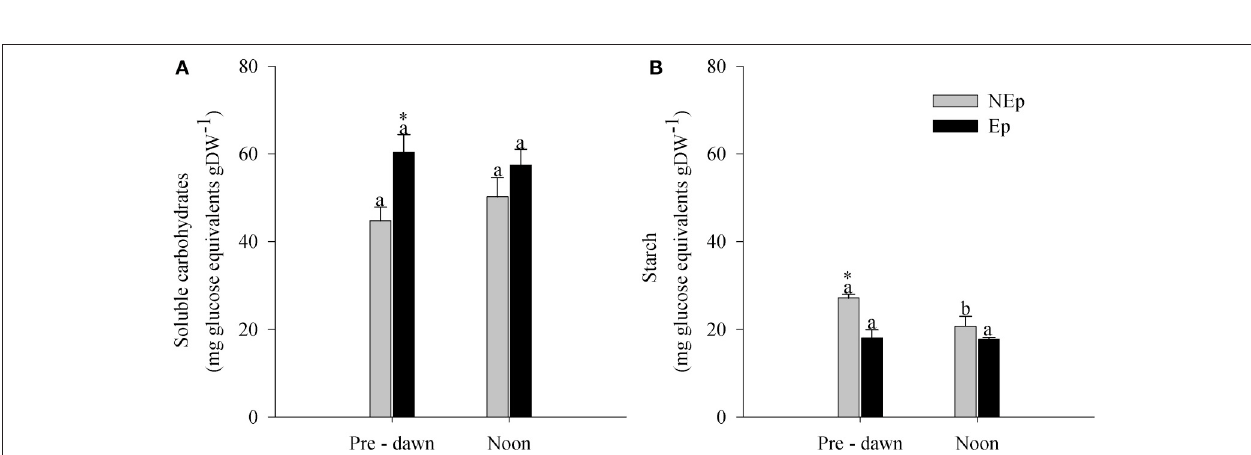
FIGURE 2 | Chlorophyll a/b ratio (A), xanthophyll cycle pool [violaxanthin (V) + anteraxanthin (A) + zeaxanthin (Z)] (B), and de-epoxidation index (A+Z/V+A+Z) (C) in Posidonia oceanica leaves with (Ep) and without (NEp) epiphytes at pre-dawn and noon. Different letters indicate significant differences between pre-dawn and noon; * indicates significant differences between Ep and NEp leaves ( n = 5 , p < 0.05 ).